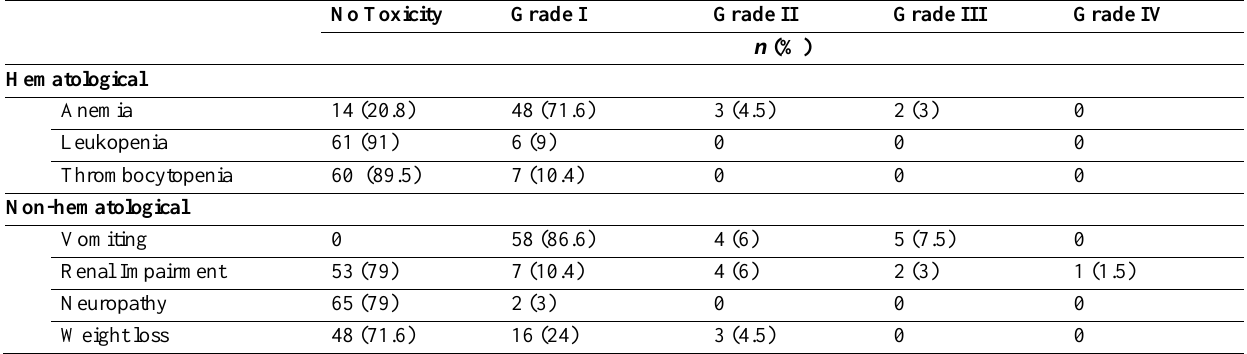
Table 3: Neoadjuvant chemotherapy – related acute toxicities